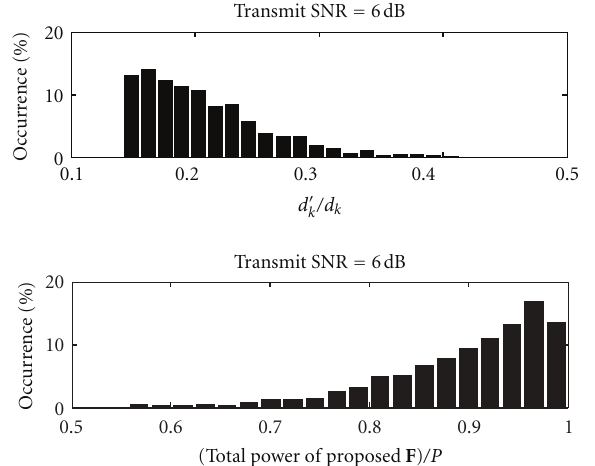
Figure 5: Eight-antenna example. Normalized SINRs for the 8 data streams for some channel realizations when the proposed algorithm is employed. The normalization factor is ρ , the SINR of every data stream when the optimum solution is